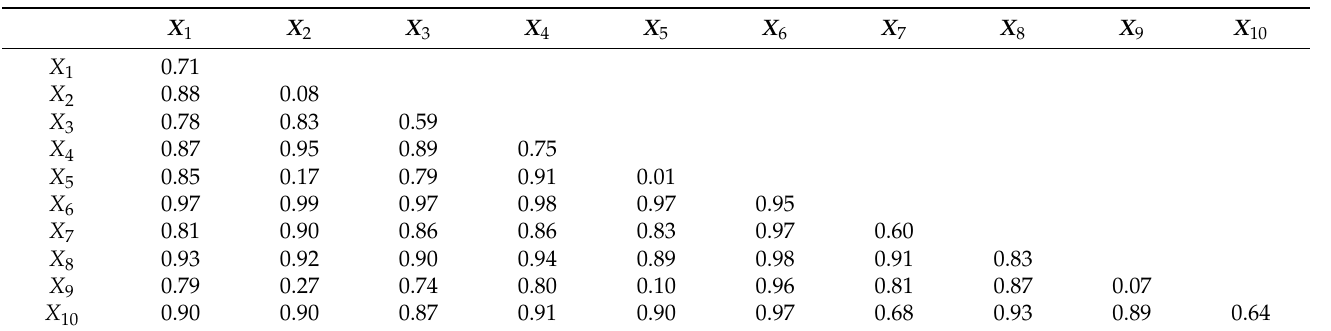
Table 6. Factor interaction analysis of the